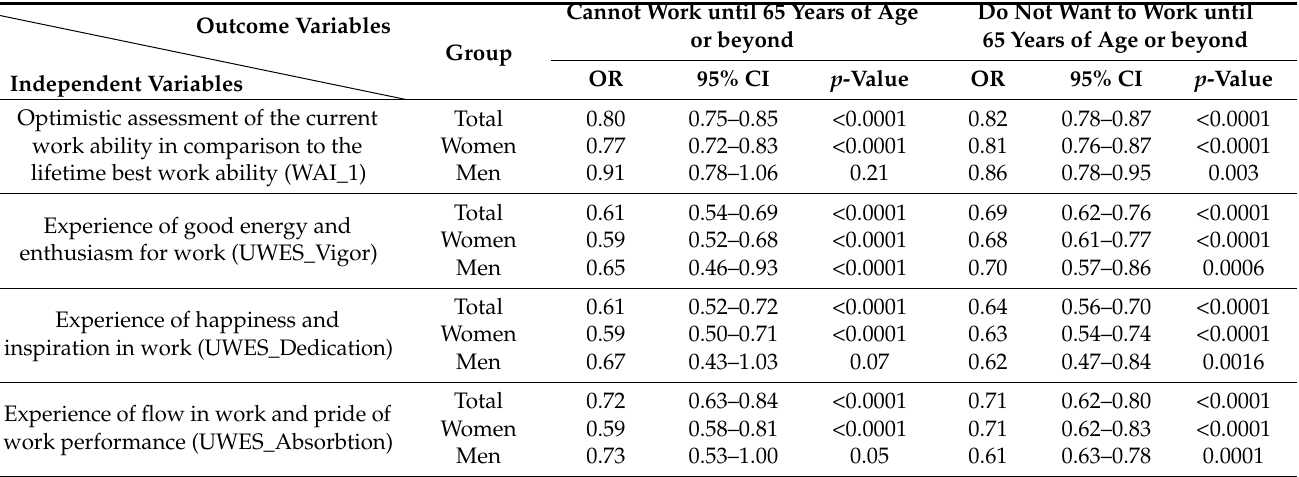
Table 3. Univariate estimates from multiple binary logistic regression with repeated measurements on school principals’ assessment of whether they “cannot work” or “do not want to work” until 65 years of age and beyond in association with the school principals’ experience of enthusiasm (continuous variables), for the total study population and stratified by sex. The results are presented confidence intervals (CsI) and p